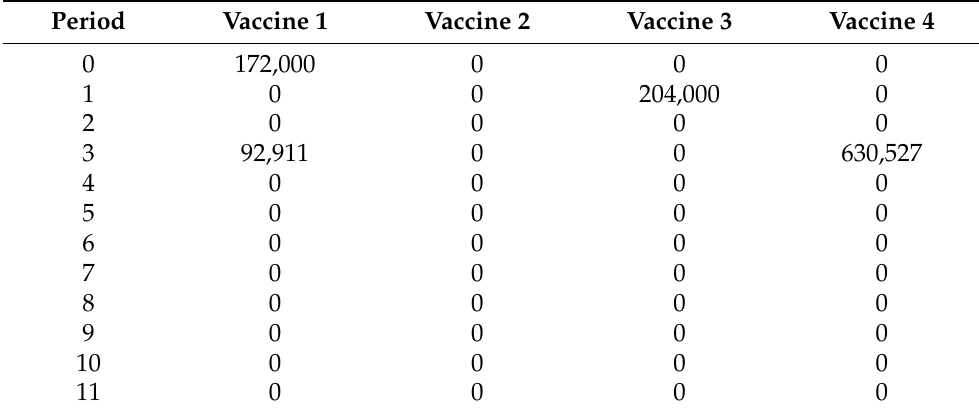
Table 7. Model PDPA—District